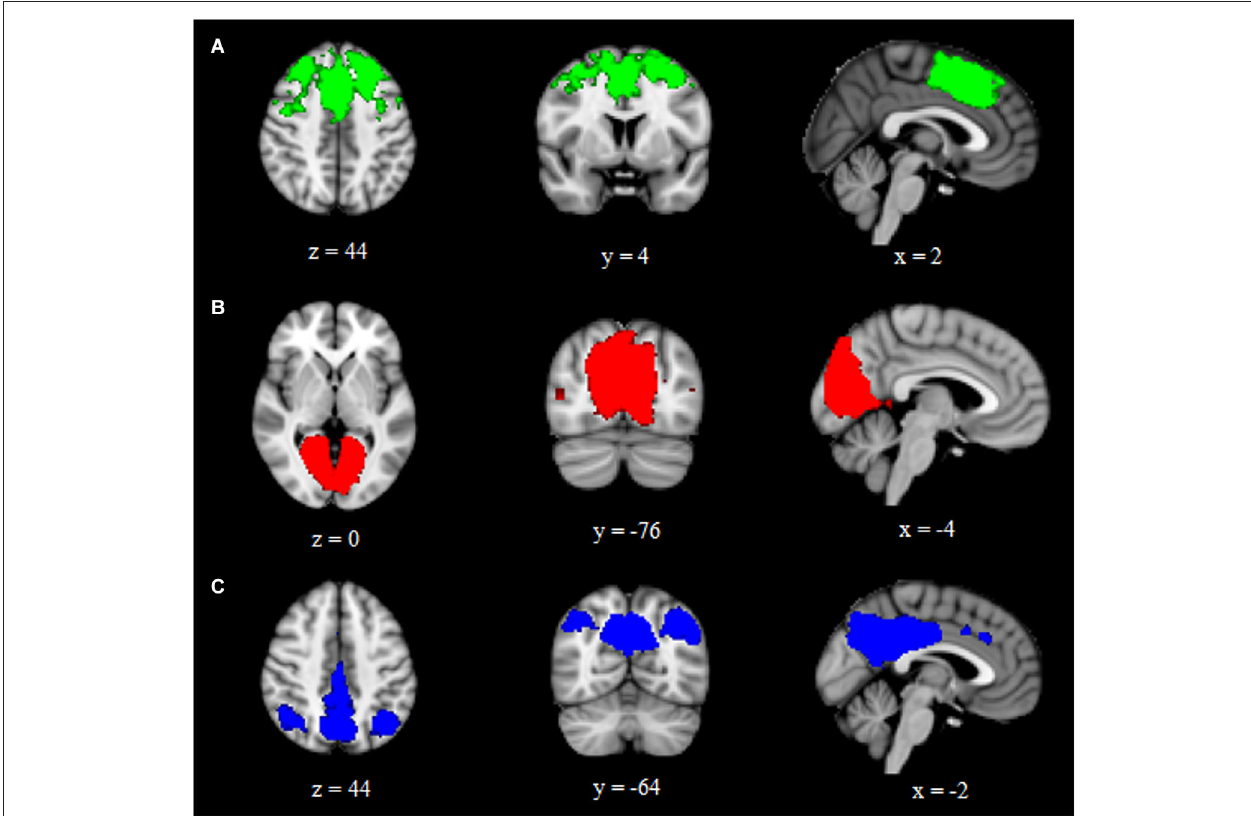
FIGURE 1 | Group ICA components representing (A) executive control, (B) primary visual, and (C) default mode intrinsic connectivity networks . Images are overlaid on the MNI152 brain and are presented in radiological orientation (right is left).